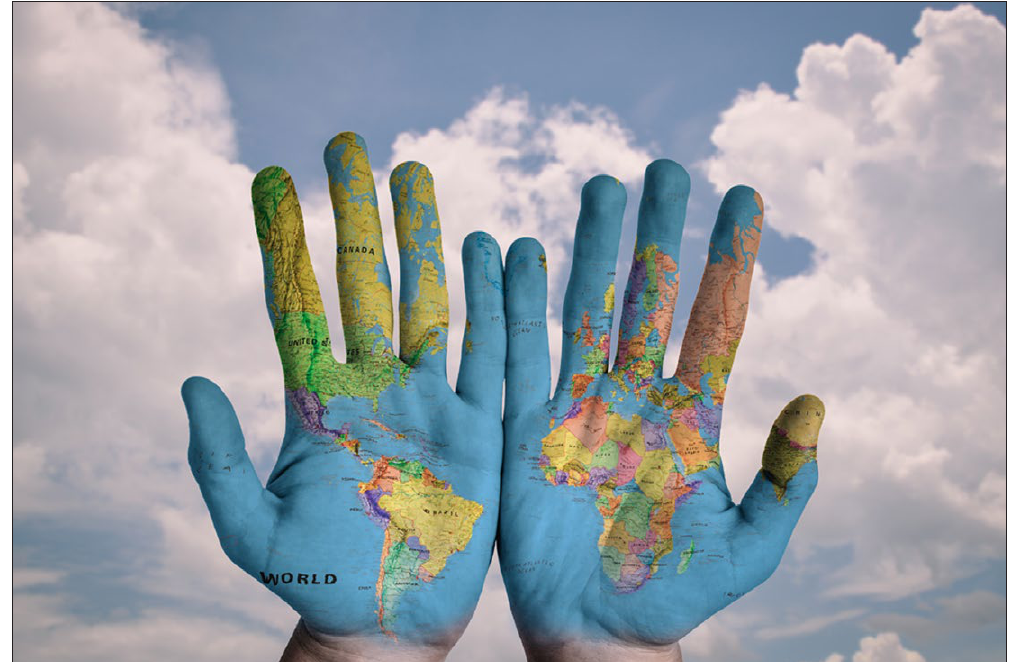
Figure 1: How will future work in citizen science choose to address research ethics? Image by Ed Gregory via